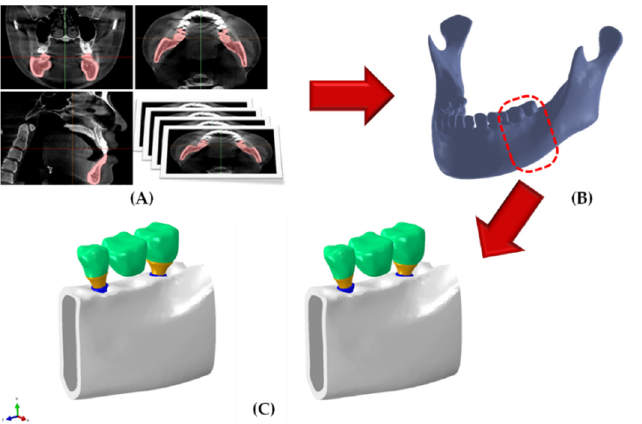
Figure 3. Mandible reconstruction and implant-supported fixed three-unit fixed dental prostheses. ( A ) Geometry data extraction from cone-beam computed tomography images; ( B ) reconstruction of surface and volume for mandible bone; ( C ) finite element analysis surgical model.